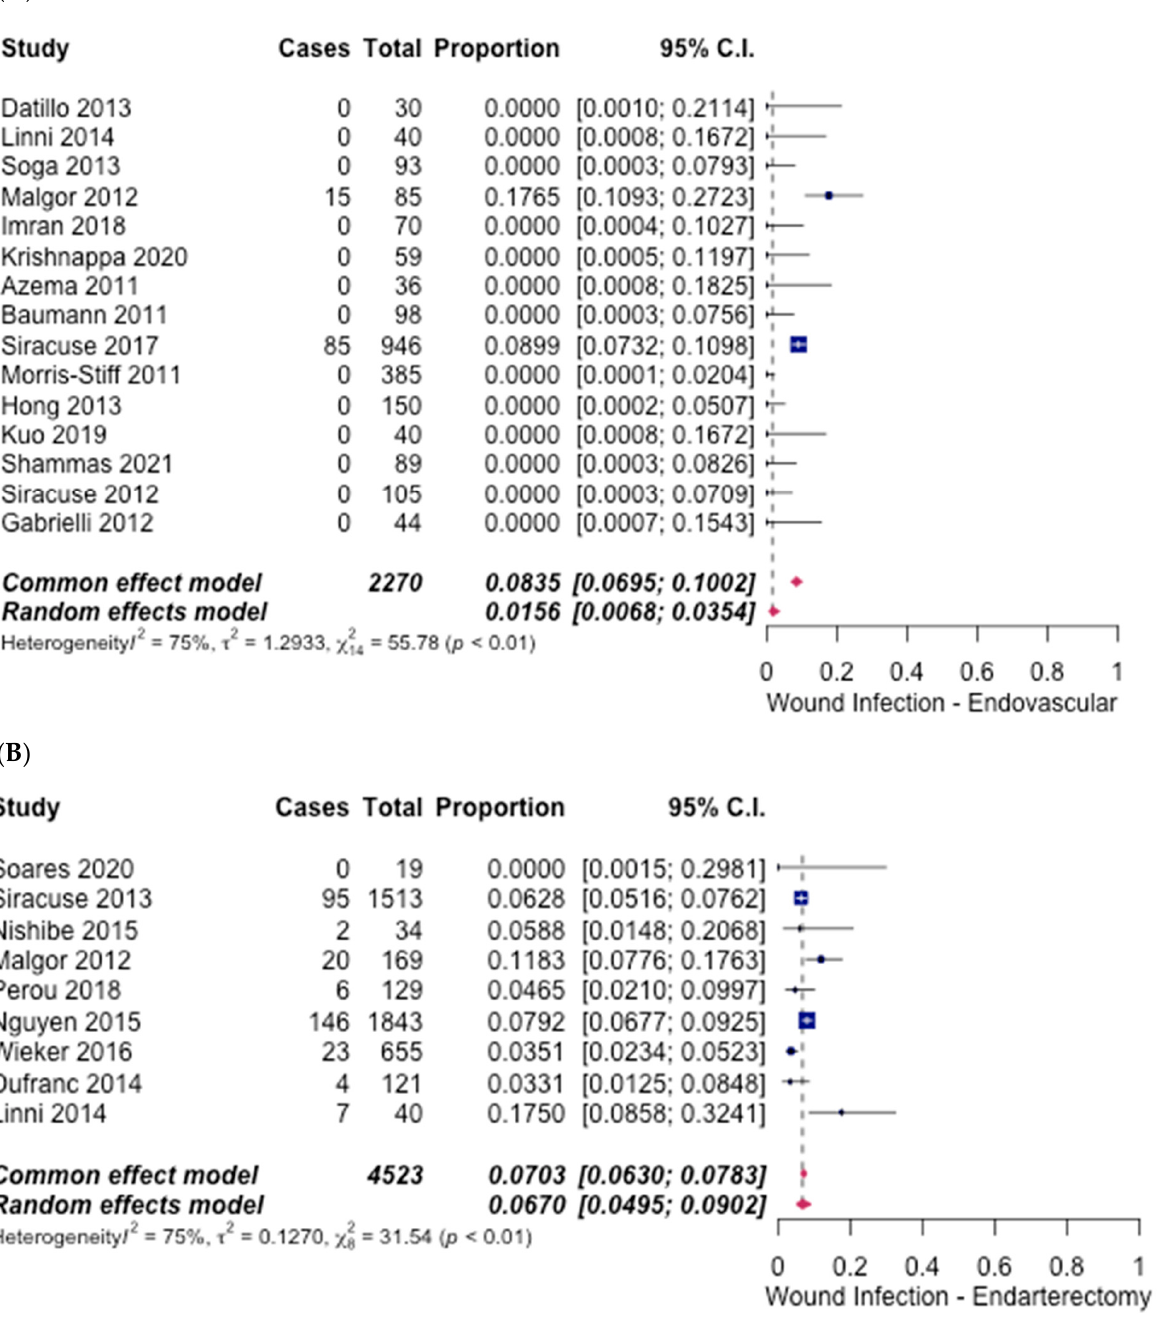
Figure 10. Forest plot for wound infection. ( A ) Endovascular intervention [6,7,10,12–22,27]. ( B ) Endarterectomy [6,23–26,28–30].